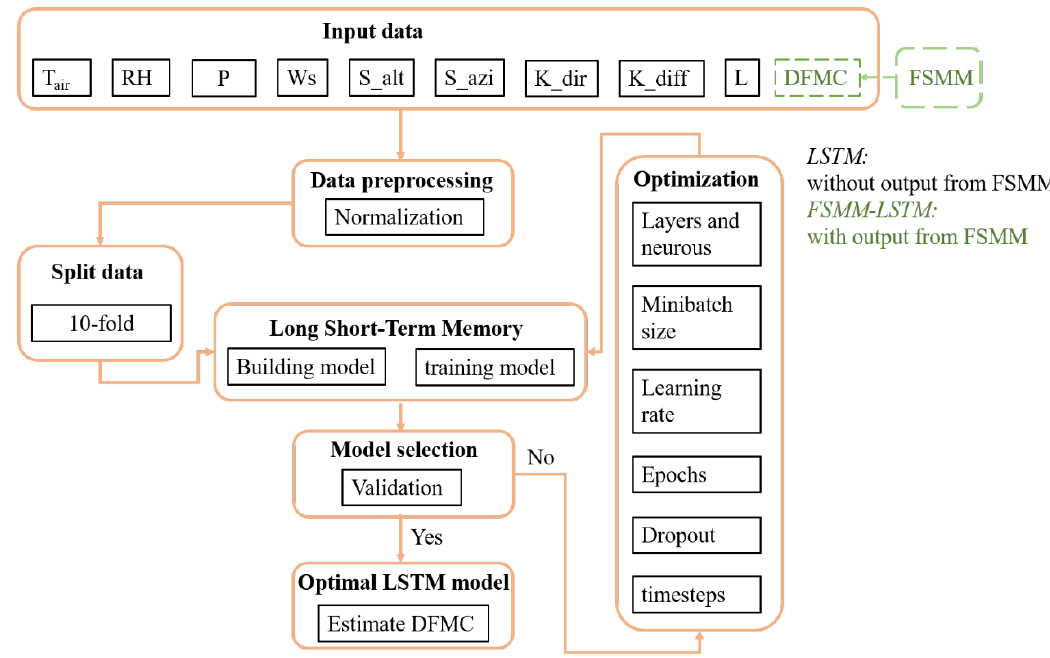
Figure 1. The flowchart of the LSTM (black) and FSMM-LSTM (black and green). Details of the input data can be found in Table 1.